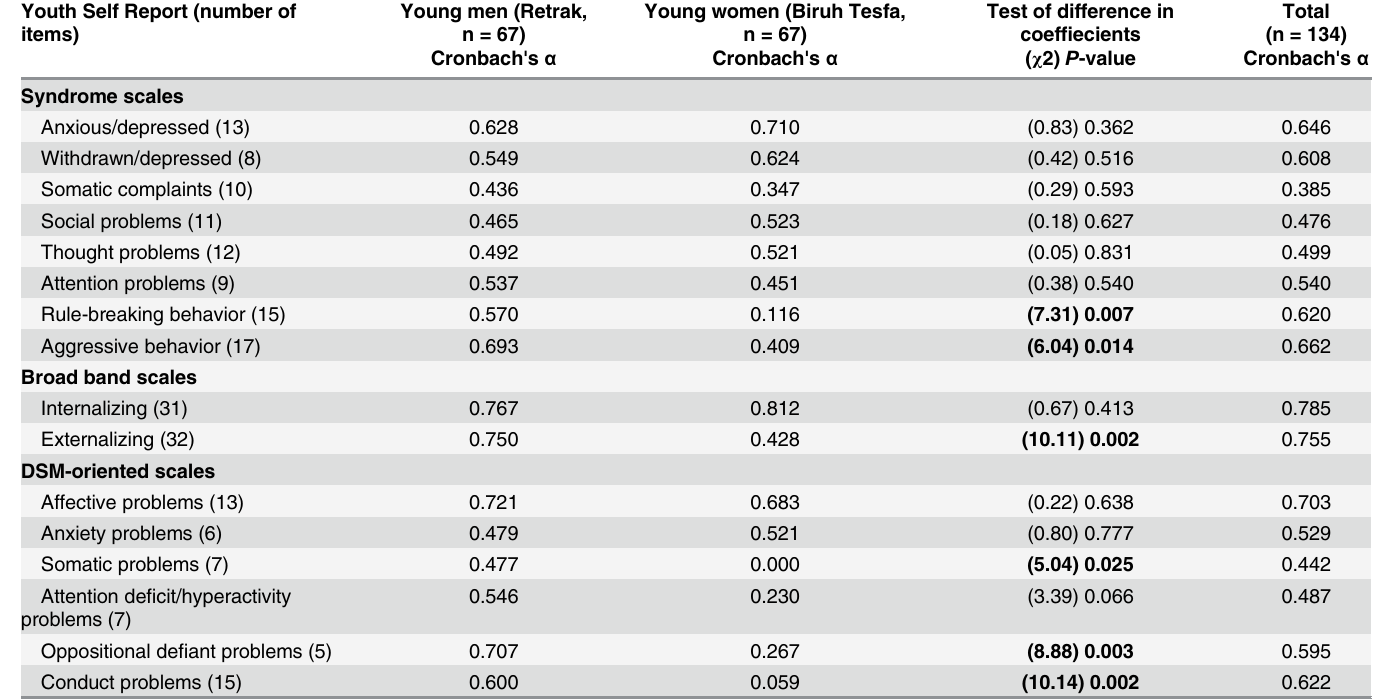
Table 2. Internal consistency of the YSR among young men and women in